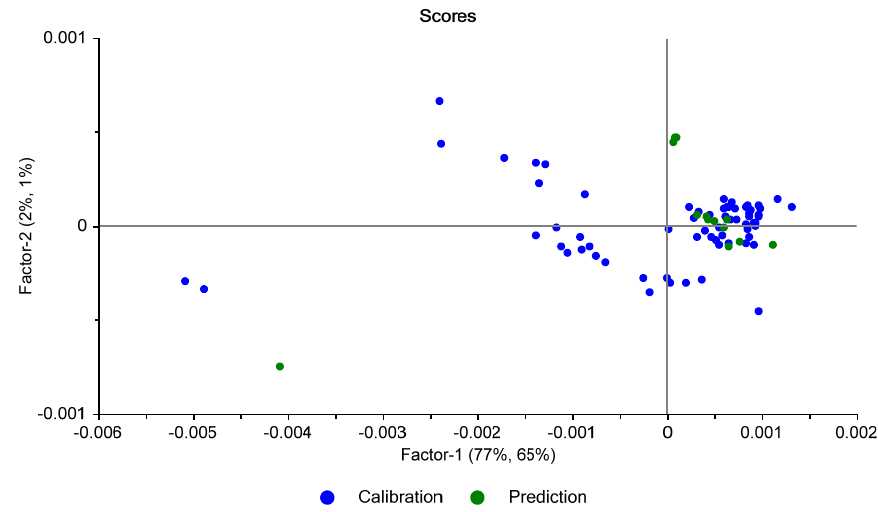
Figure 23. Scores plot of the calibration and test set spectra. The prediction results are shown in Table 11, alongside the reference measurements. Most of the moisture predictions were relatively close, with a mean prediction error of +0.36% w / w . The RMSEP (root mean square error of prediction) was 0.93% w / w , with a R 2 pred of 0.52. Table 11. Prediction and reference results for the independent test set. Tebuthiuron Tebuthiuron Moisture by Moisture by Prediction Prediction by NIR by HPLC NIR (%) Drying (%) Error (%) Error (mg/g) (mg/g) (mg/g) 9.74 ± 1.34 − 1.26